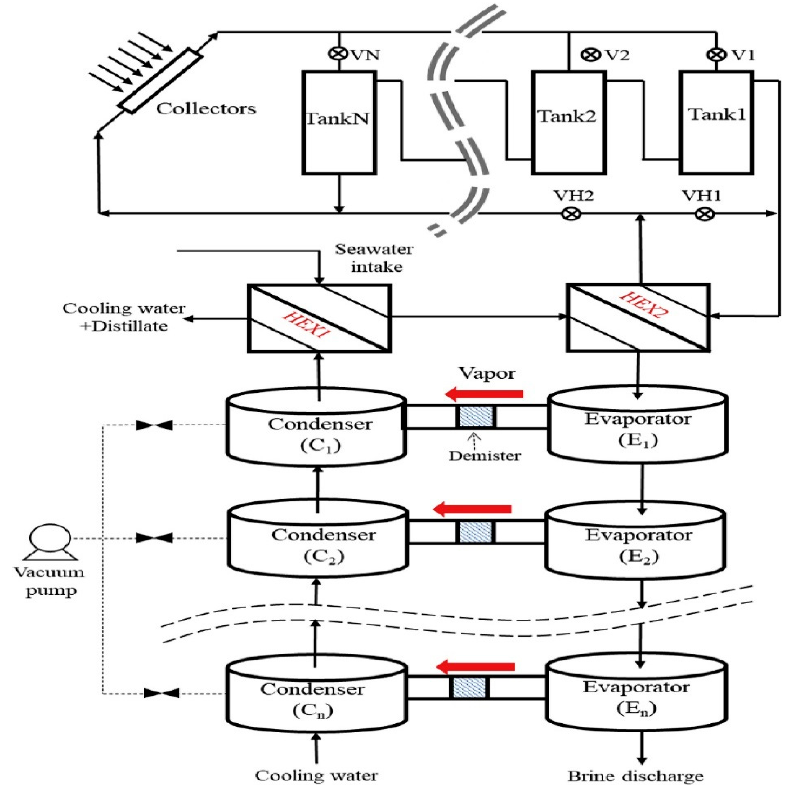
Figure 8. Solar spray-assisted low-temperature WDS integrated with TES [86], reused with permission from Elsevier (license number 5491421395079).